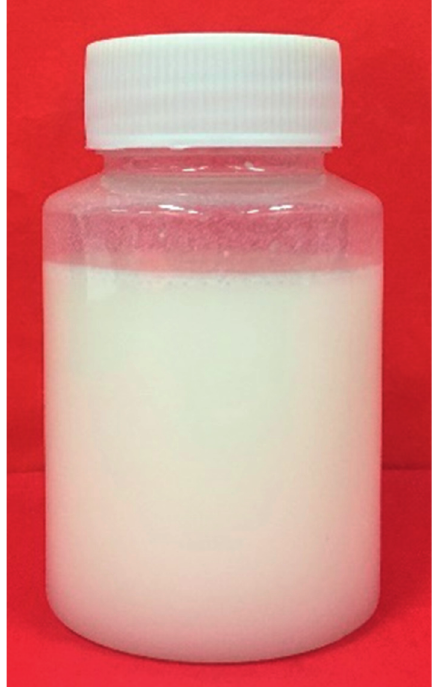
Figure 6: Submillimeter-scale SMG aqueous solution before aging.